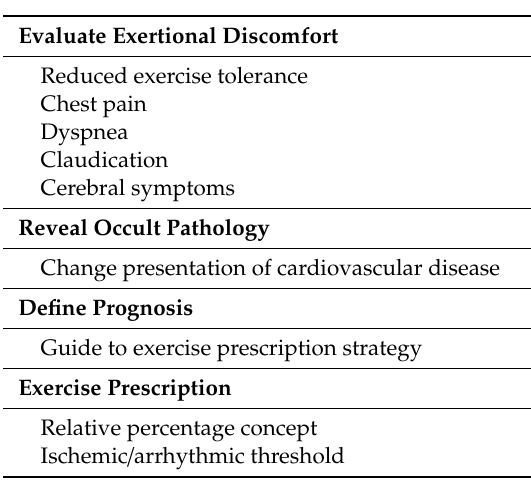
Table 2. Reasons for exercise